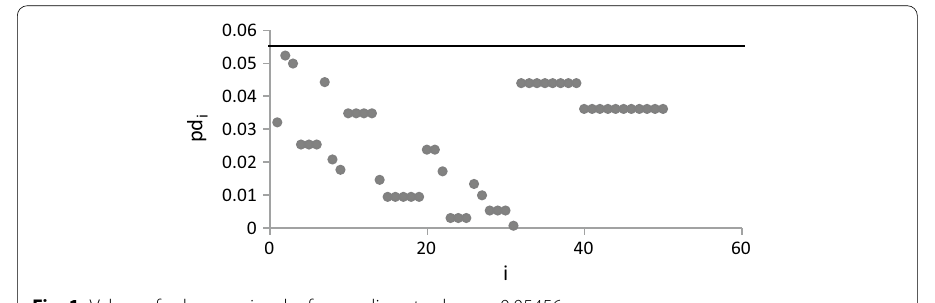
Fig. 1 Values of pd i versus i and reference line at value c